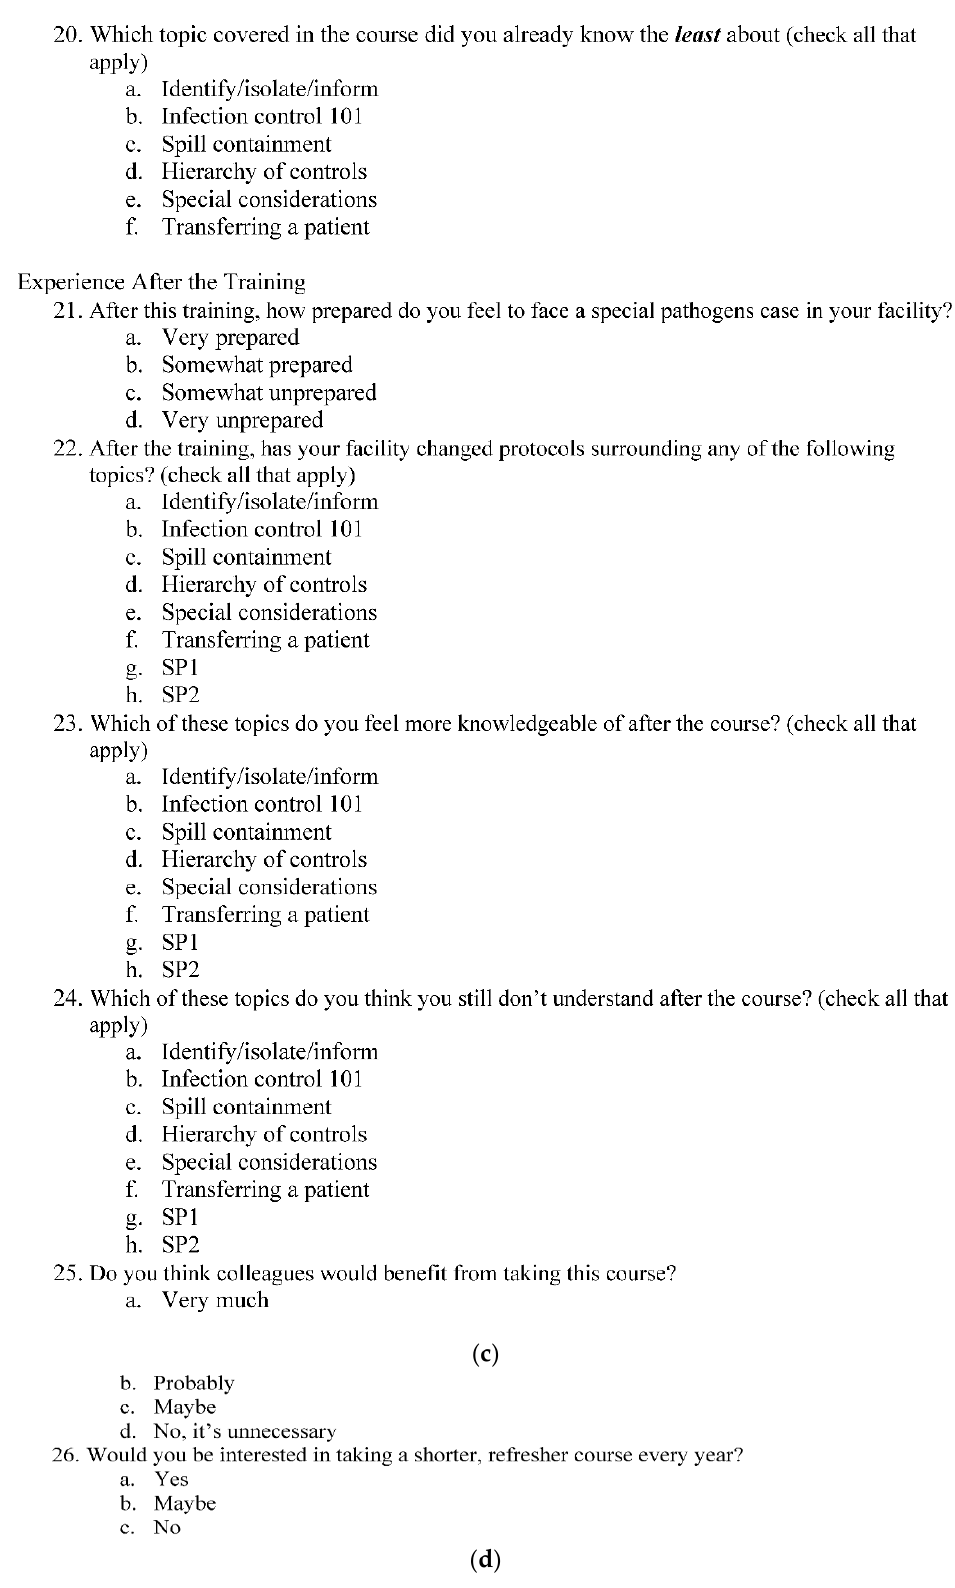
Figure A1. Survey given to each participant 1 week before the course and 3 months after the course to assess any change in preparedness ( a – d ). Questions are divided into multiple-choice knowledge-based questions, scaled subjective questions, and free-response questions.